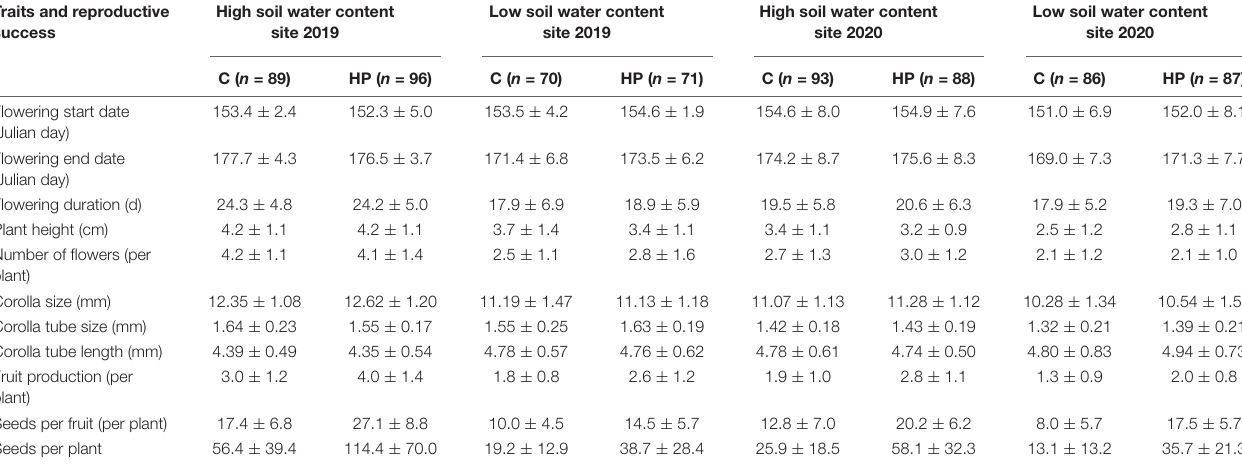
TABLE 2 | Floral traits and reproductive success (mean ± SD) of Primula tibetica in 2019 and